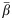
Crosstalk features in k-mer-based CLASH subnetworks and in their randomized counterparts.(a, b) Mean and maximum susceptibilities as functions of β¯. (c) Pearson coefficient ρ¯ quantifying crosstalk locality. (d) Coefficient of Variation of the levels of free RNAs as a function of β¯. The degree of TH is fixed at CVtr = 0.4 (with averages performed over 1000 independent realizations of TH) and high BH is assumed. In each case, the standard error of the mean is equal to or smaller than the size of the markers. The term ‘CLASH-noseed’ indicates the full CLASH interactome except for ‘noseed’ type of interactions.